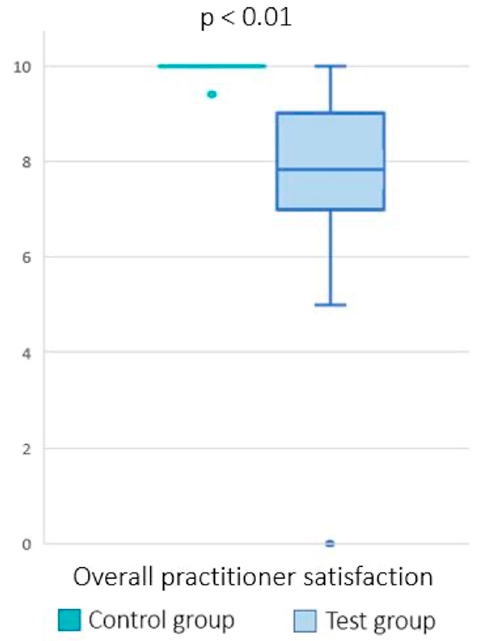
Figure 3. Overall practitioner satisfaction after a face-to-face consultation (control group) and after a teleconsultation (test group). The dots represent the outlier values.